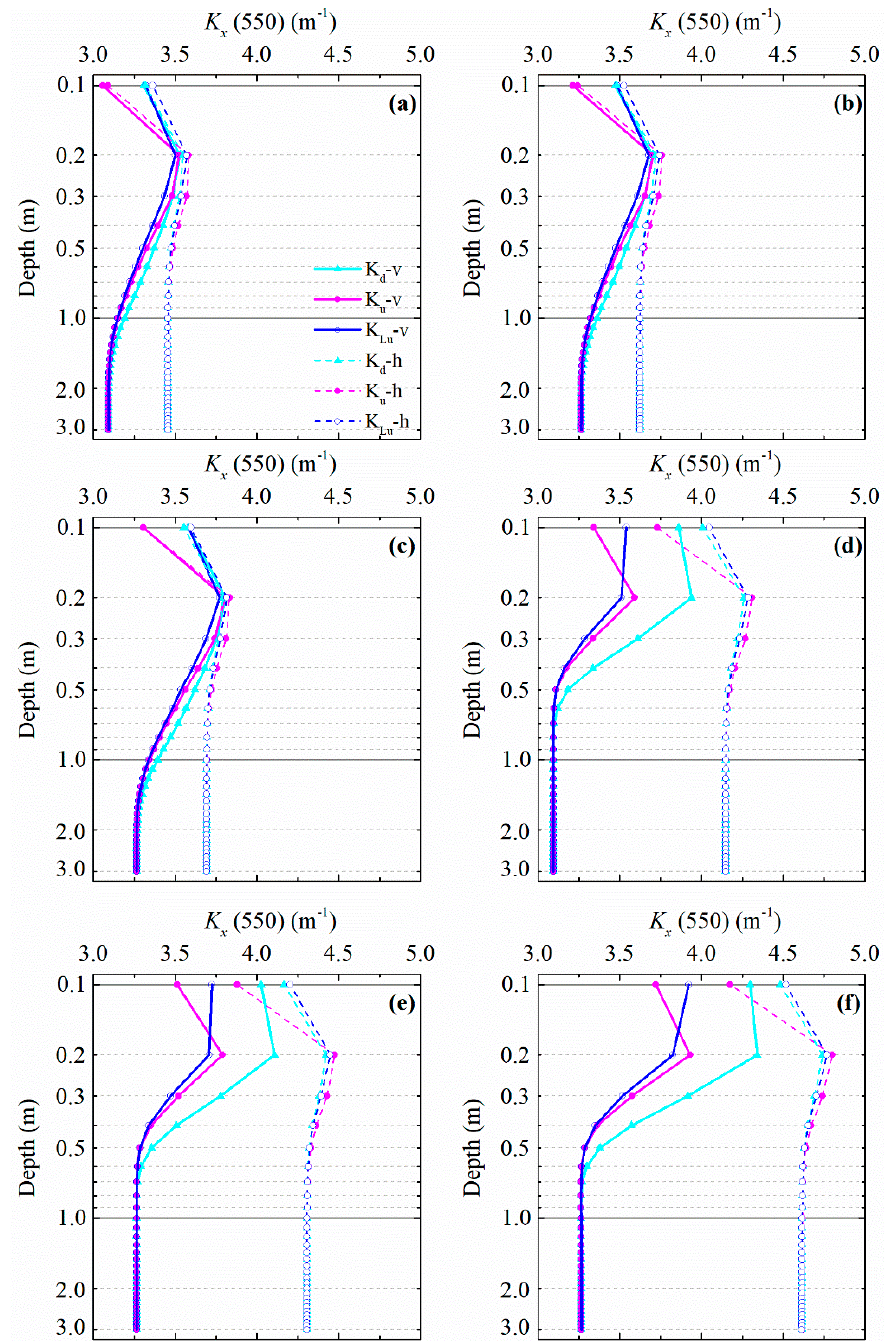
Figure 5. K x (550) vertical profiles under di ff erent Chl a (z) distributions: ( a ) L1 (5, 16, 0.6), ( b ) L2 (10, 16, 0.6), ( c ) L3 (10, 21, 0.6), ( d ) L4 (5, 16, 0.2), ( e ) L5 (10, 16, 0.2), and ( f ) L6 (10, 21, 0.2). K x represents K d , K u , and K Lu . The solid lines represent the K x (550, z) profiles in vertical inhomogeneous waters (“v”); the dashed lines represent the corresponding cases in vertical homogeneous waters (“h”).